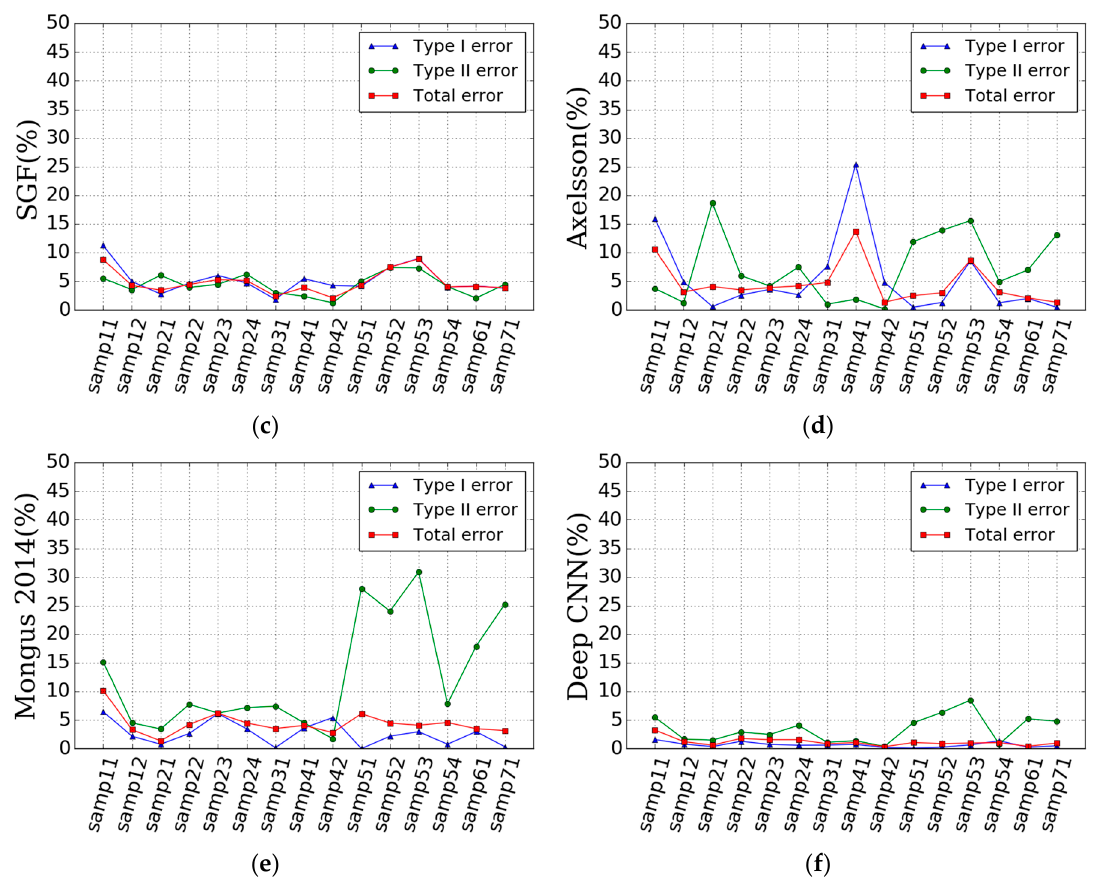
Figure 6. Detailed comparison with other methods and the proposed algorithm across 15 samples in the ISPRS dataset: ( a ) error rates of Terrasan, ( b ) error rates of Mongus 2012, ( c ) error rates of SGF, ( d ) error rates of Axelsson, ( e ) error rates of Mongus 2014, ( f) error rates of Deep CNN. We also compare deep CNN model with TerraScan on 40 cases from the test ALS data with various terrain complexities in the aspects of both error rates and root mean square error of DTM. The comparison of error rates is shown in Figure 7 and comparison of root mean square error (RMSE) between the generated DTM with the ground truths is shown in Figure 8.